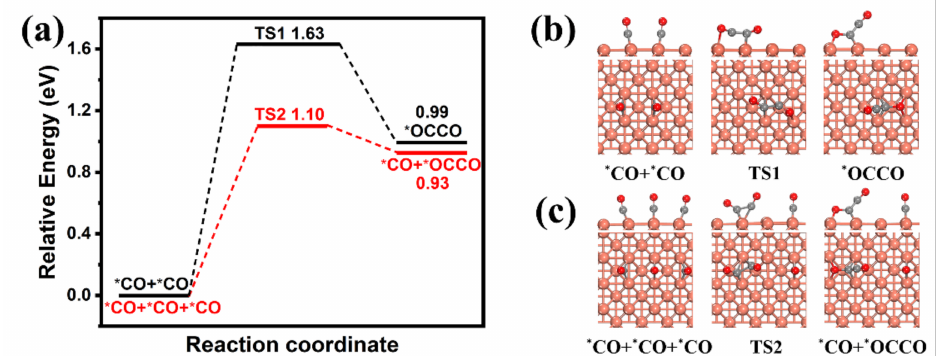
Figure 5. ( a ) Reaction barrier energies of C-C coupling step at the low and high CO concentrations; the corresponding configurations of initial state, transition state and final state on the CO coverage of ( b ) 2/9 ML and ( c ) 3/9 ML. Light red, copper; grey, carbon; red, oxygen; TS, transition state; * represents